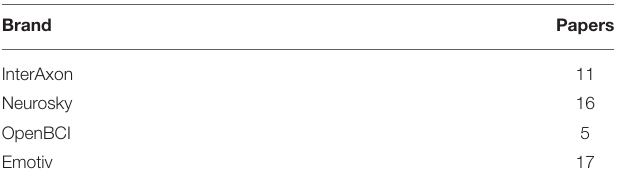
TABLE 2 | Relevant results after search